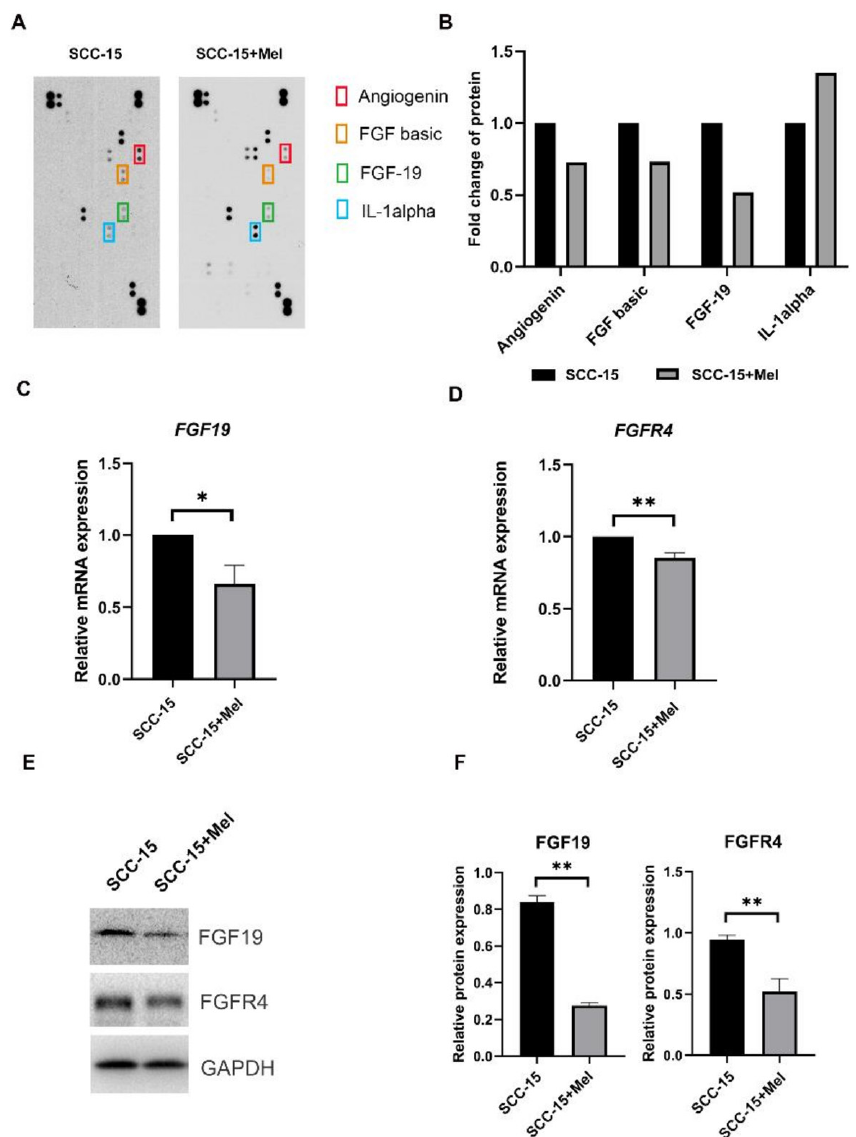
Figure 2. Melatonin-induced inhibition of FGF19 and FGFR4 expression (mRNAs and proteins) in Scheme 15. cells. Relative expression levels of 105 cytokines after being treated with 2 mM Mel or not for 24 h ( A ). Four cytokines with remarkable changes in intensity were highlighted ( B ). Expression levels of FGF19 and FGFR4 were determined by qPCR ( C , D ) and Western blot ( E ). The Western blot data were obtained from three independent replicates ( F ). * p < 0.05, ** p <